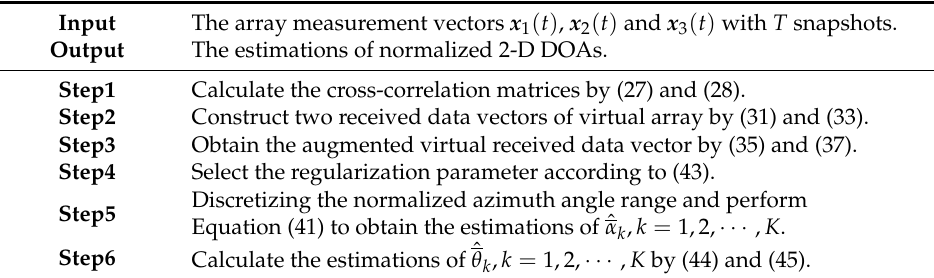
Table 3. Steps for 2-D DOA estimation method using